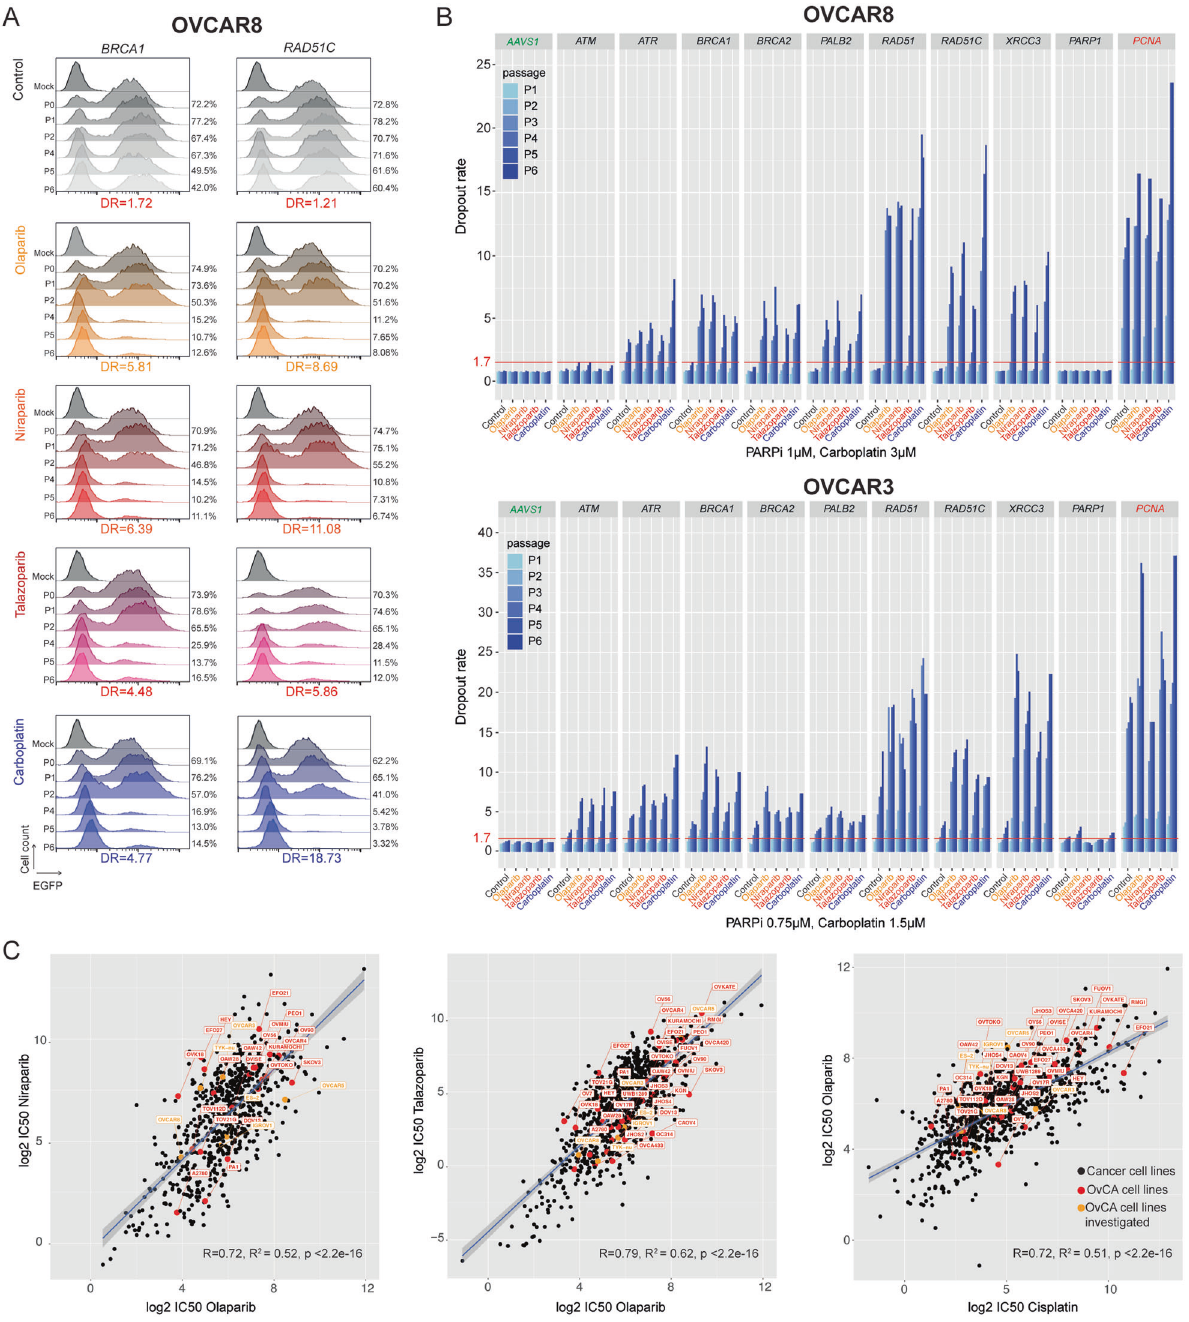
Fig. 4 PARPi sensitivity correlates with chemotherapy response. A Representative histograms from fl ow cytometry analysis for the enhanced PARPi sensitivity and carboplatin in cells harboring gRNAs targeting BRCA1 and RAD51C . B Histograms for CRISPR- Cas9 cell competition assay over 6 consecutive passages with increased dropout rates in cells treated with different PARPi and carboplatin. The threshold for essentially was de fi ned as >1.7 dropout rate in the non-treated conditions. C Scatter plots demonstrating a positive correlation between olaparib, niraparib, talazoparib, and cisplatin. Data obtained from the DepMap portal (accessed in January 2022) R and R 2 indicate the correlation coef fi cient and square correlation coef fi cient,